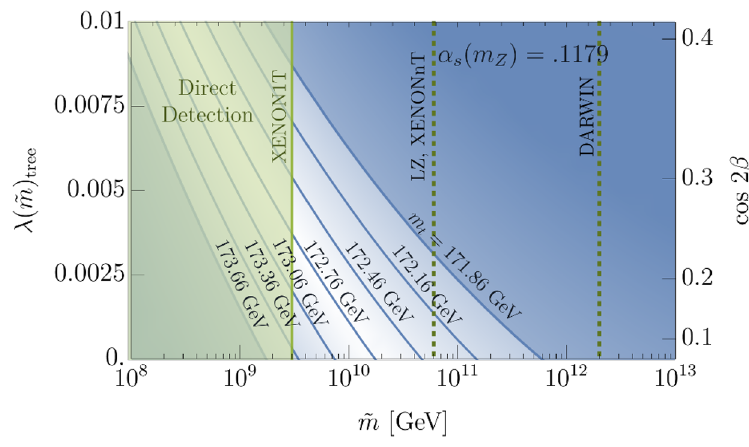
Figure 3 . Prediction for the top quark mass as a function of the sparticle mass scale, ˜ m , and the tree-level Higgs quartic coupling at ˜ m . Contours of m top span 3 σ above and below the current central value for m top , (172 . 76 ± 0 . 30) GeV . For Higgsino or sneutrino LSP dark matter, the green shaded region is excluded by XENON1T and dotted green lines show the sensitivities of future experiments. Values of m t are experimentally disfavored in the dark blue